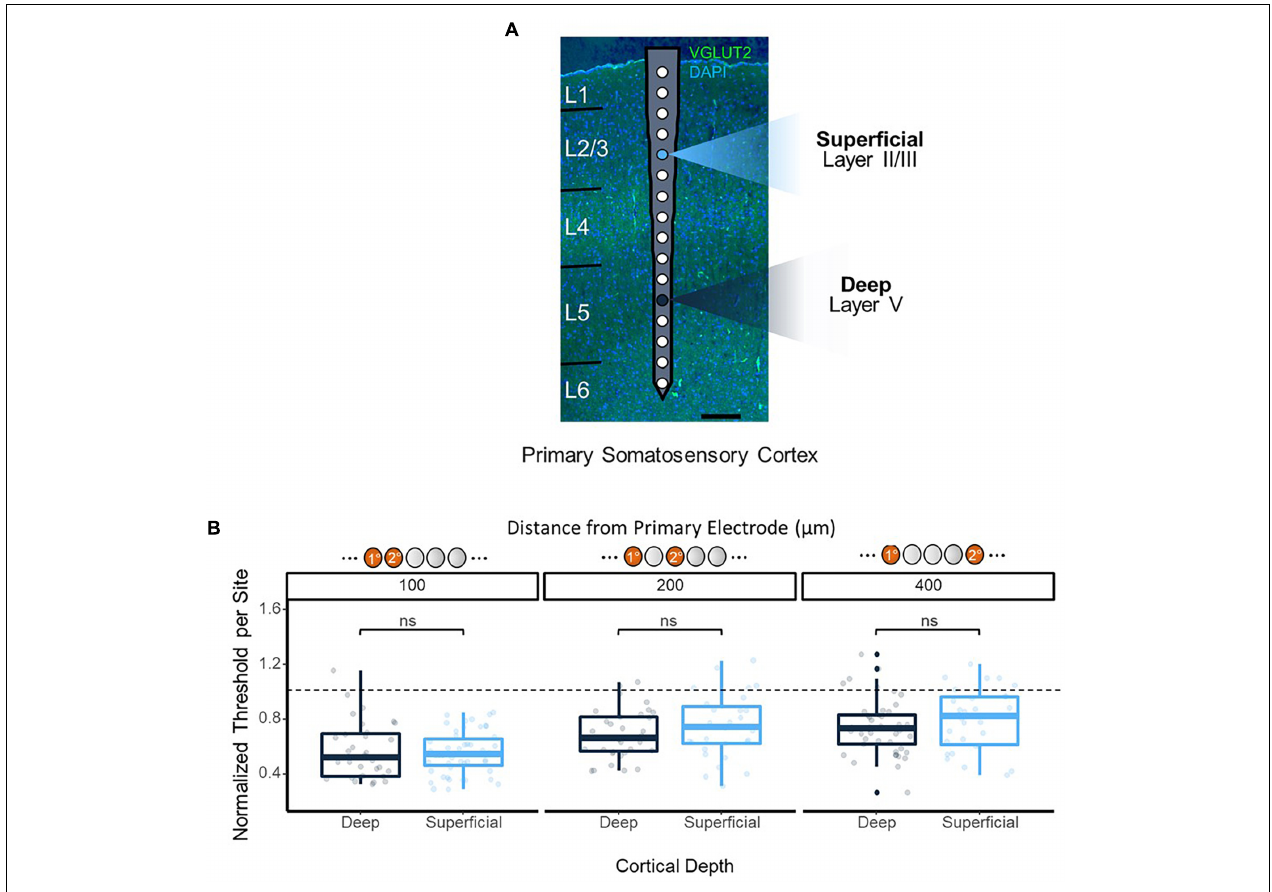
FIGURE 4 | Synchronous stimulation effects over cortical depth. (A) Overlay of electrode on histological image to show positioning. Histology performed on coronal section of the implantation site stained with VGLUT2 and DAPI to enable layer identification. Two primary electrode sites were tested: 450 µ m from the cortical surface as a shallow site, and 1,150 µ m as a deep site (highlighted). (B) Consistency of 2-site stimulation effects on threshold over cortical depth. Secondary electrode sites located ± 100, 200, and 400 µ m from the primary electrode were stimulated, and data from each absolute distance was grouped together. Threshold charges were normalized to the average single-site stimulation threshold charges obtained from the primary electrode site for each